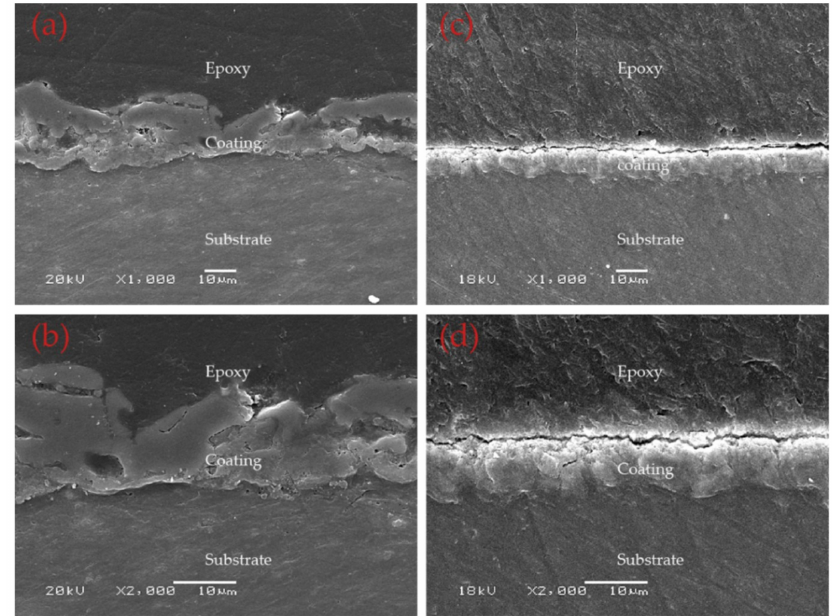
Figure 3. ( a ) Cross-section morphologies of MgO coating at 1000 × , ( b ) cross-section morphologies of MgO coating at 2000 × , ( c ) cross-section morphologies of ZrO 2 coating at 1000 × , and ( d ) cross-section morphologies of ZrO 2 coating at 2000 × .